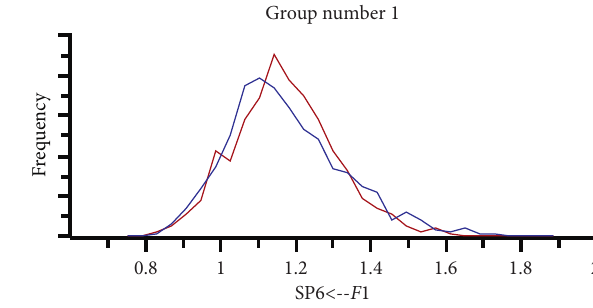
Figure 4: Bayesian diagnostic SP7.